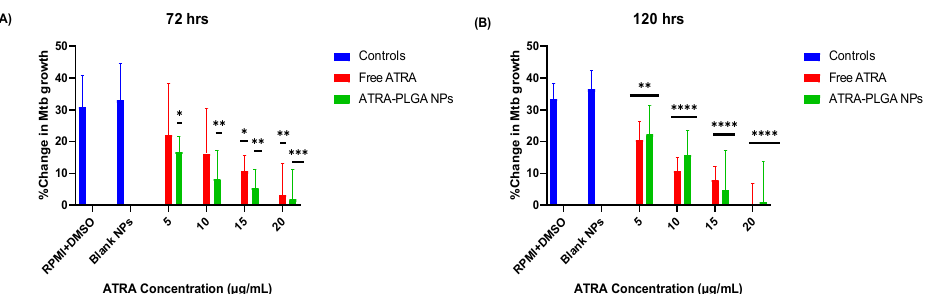
Figure 4. In vitro treatment with ATRA reduced the growth of H37Ra Mtb. Baseline infection levels of THP-1 cells infected with H37Ra were measured at 3 h post-infection followed by cells treatment. Treatment groups were RPMI and DMSO (DMSO at 0.4% v/v -corresponding to the highest volume used with free ATRA), Free ATRA solution (5, 10, 15, 20 μ g/mL), unloaded-PLGA NPs (blank NPs), and ATRA-PLGA NPs (equivalent to 5, 10, 15, 20 μ g/mL of ATRA). Treatment efficacy was assessed at ( A ) 72 h, and ( B ) 120 h, after treatment using the BacT/Alert ® 3D culture system (bioMerieux) by calculating the % change in bacterial growth. MOI: 1–10 per cell (n = 3). Statistical analysis was per- formed using two-way ANOVA with Tukey’s post-hoc test comparing RPMI and DMSO, and blank NPs groups as reference. * p < 0.05, ** p < 0.01, *** p < 0.001, and **** p < 0.0001.